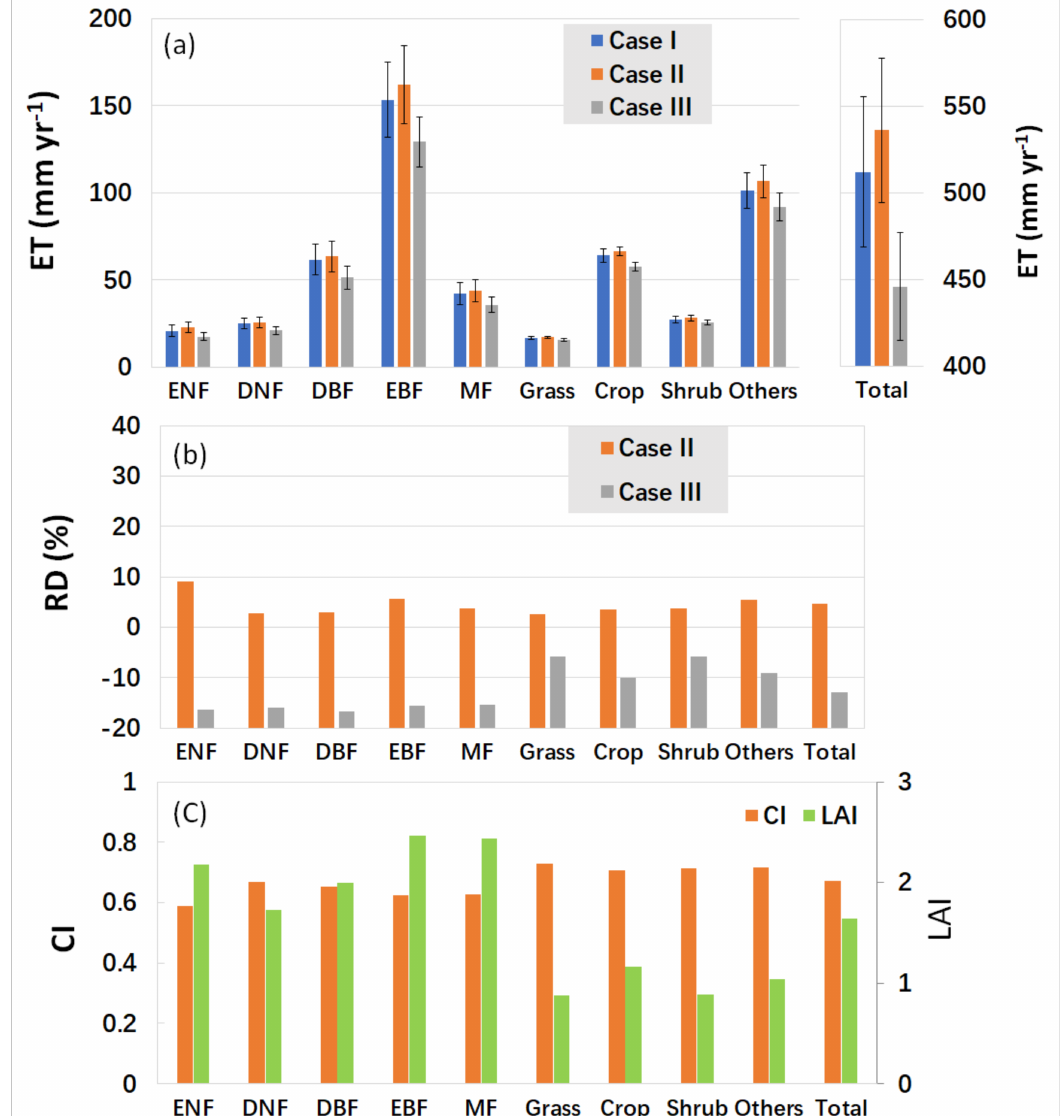
Figure 8. BEPS simulated ET of the various PFTs ( a ); the relative differences (RD) of Case II and Case III were both compared to Case I ( b ). CI and LAI of various PFTs ( c ). Case I: the true LAI and CI are used; Case II: the true LAI is used while clumping is ignored; Case III: effective LAI is used ignoring clumping. ENF: evergreen needleleaf forests; DNF: deciduous needleleaf forests; DBF: deciduous broadleaf forests; EBF: evergreen broadleaf forests; MF: mixed